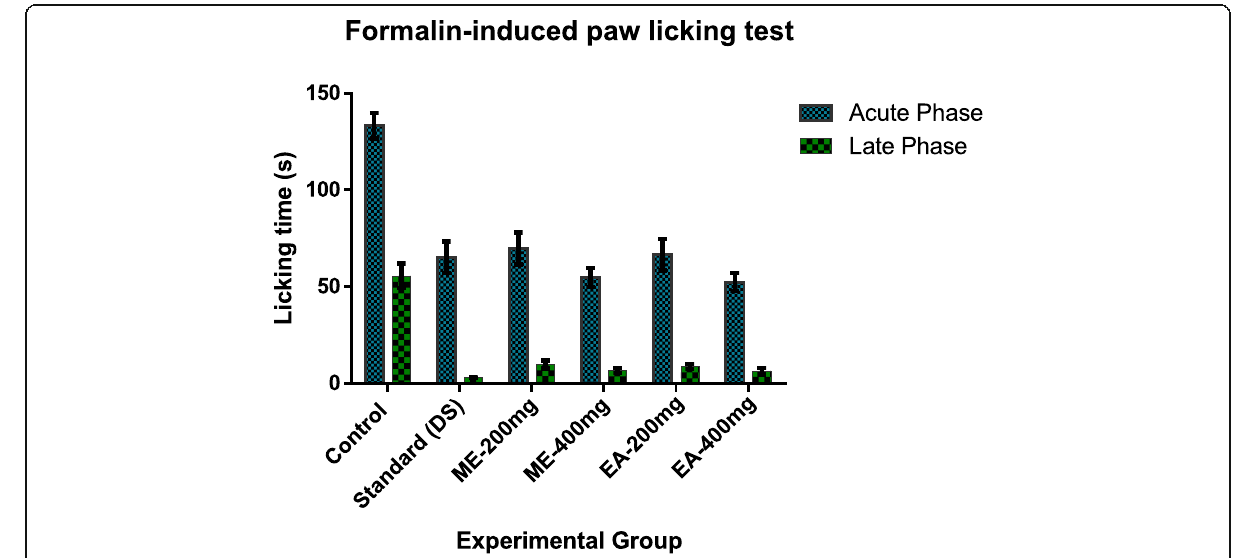
Fig. 3 Effect of Hemigraphis alternata methanolic and ethyl acetate extract treatment on formalin-induced paw licking in mice. Each bar represents the mean ± standard error of the mean of paw licking time (s) of five animals